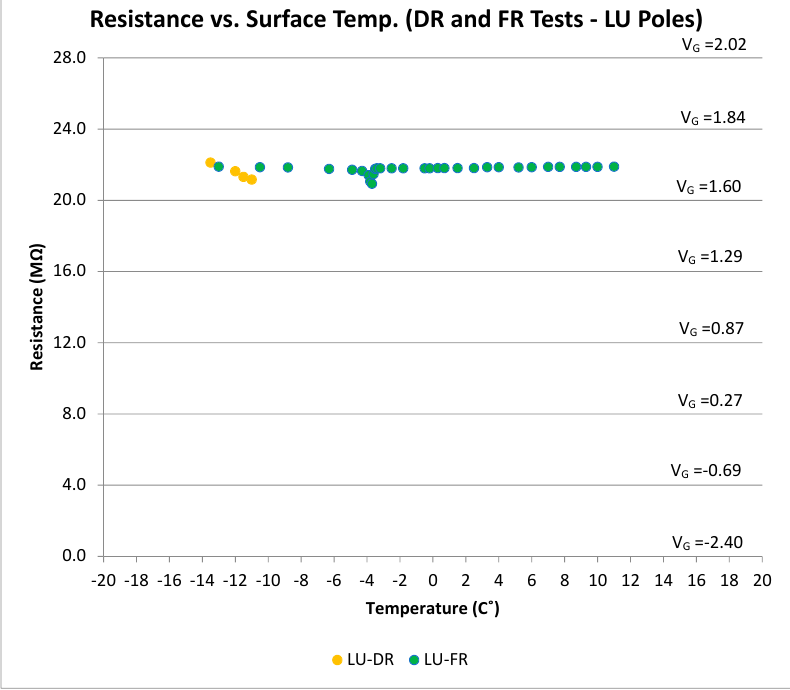
Figure 11. Resistance (and voltage) vs. surface temperature for DR and FR tests (LU Poles).